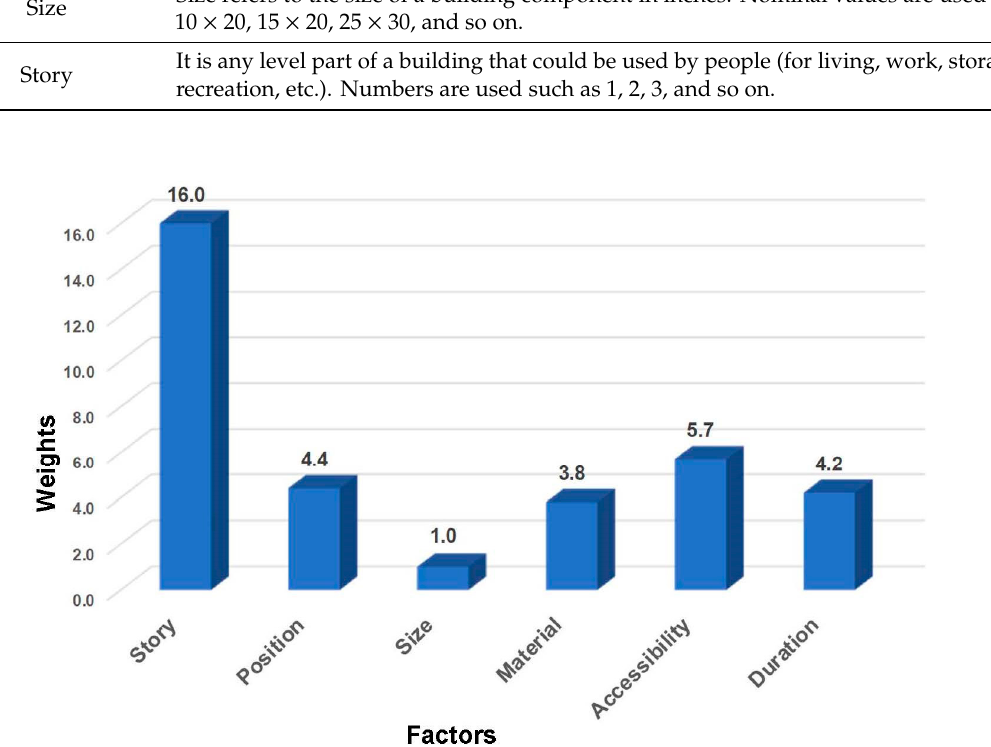
Figure 4. Factor weights for window case selection.